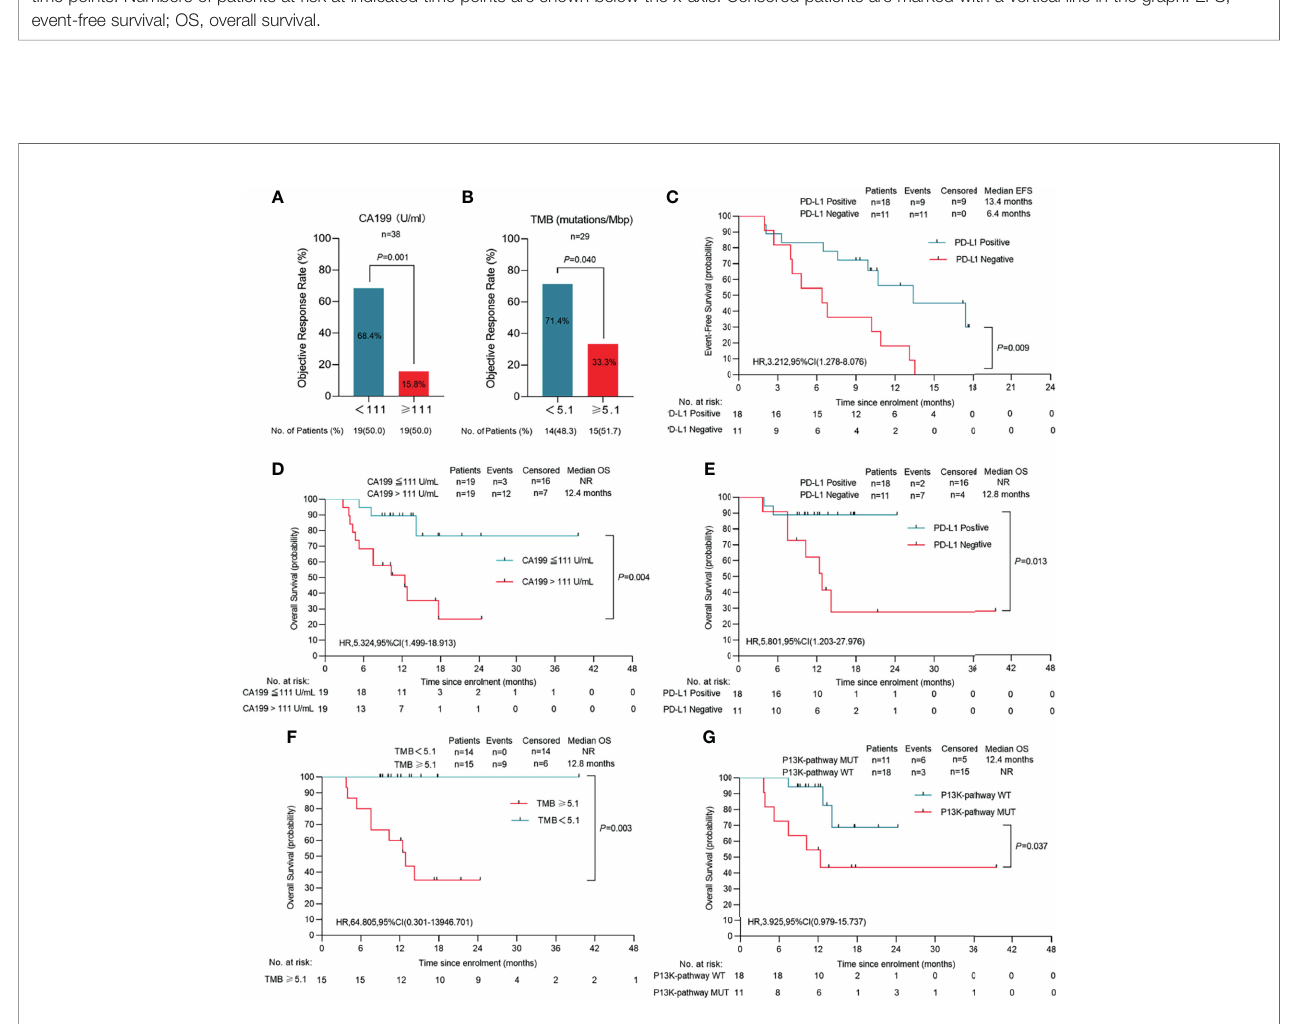
FIGURE 5 | Clinical response in relation to tumor biomarkers in patients with initial unresectable BTC. (A) The cutoff value of CA199(CA199 = 111 U/mL) is three times the normal value of our institution (n=38). (B) TMB was calculated by summing up somatic mutations within the coding regions by whole-exon sequencing. A TMB of 5.1 mutations per million base pairs (Mbp) was the cutoff value (n=29). (C) Event-free survival of patients of PD-L1 positive or PD-L1 negative (n=29). (D) Overall survival of patients of CA199 ≤ 111 U/ml and CA199 > 111U/ml (n=38). (E) Overall survival of patients of PD-L1 positive or PD-L1 negative (n=29). (F) Overall survival of patients of TMB<5.1 mutations/Mbp or TMB ≥ 5.1 mutations/Mbp (n=29). (G) Overall survival of patients of P13K-pathway wide type and P13K-pathway mutation (n=29). Probability of survival is shown at indicated time points. Censored patients are marked with a vertical line in the graph. Numbers of patients at risk at indicated time points are shown below the x-axis. NR, not